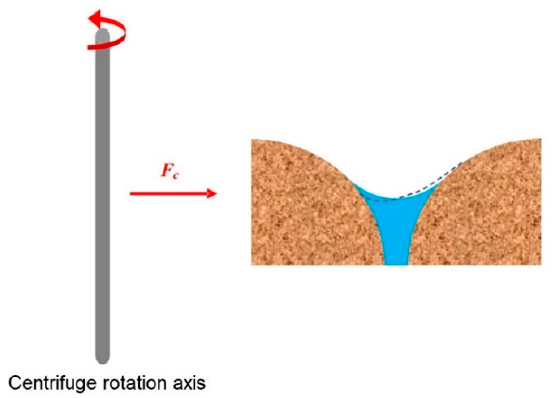
Figure 1. Distortion of the air–water interface under the effect of the centrifugal force, F c .